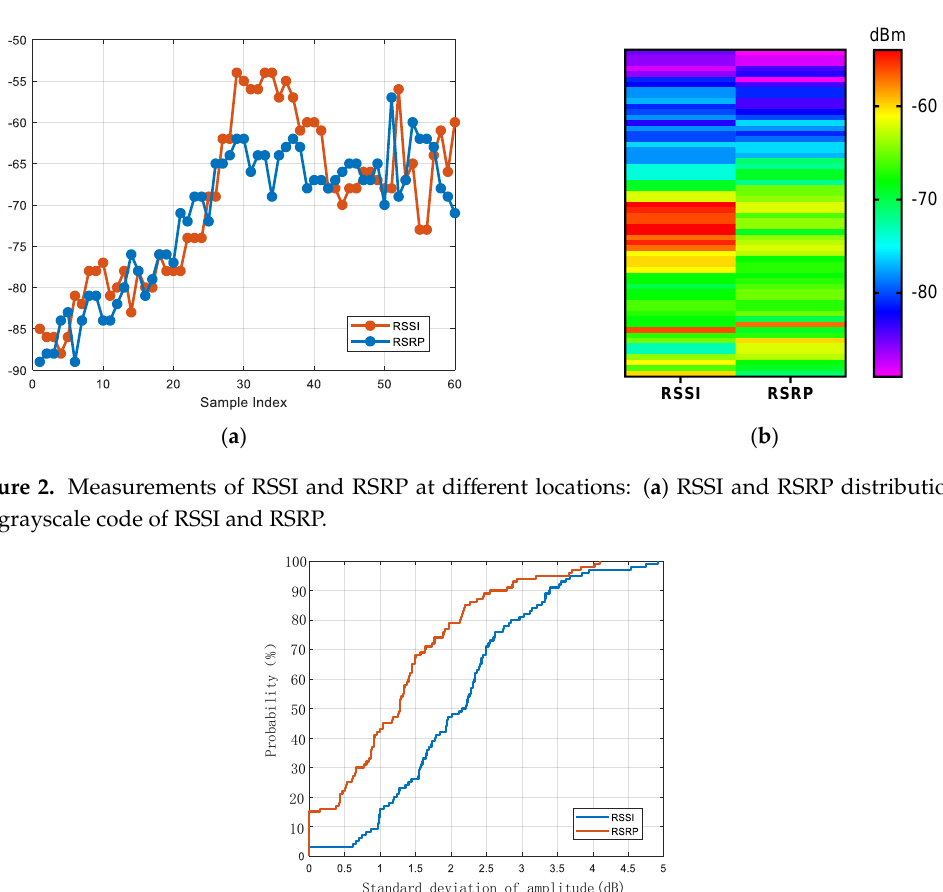
Figure 3. Cumulative distribution function (CDF) of the standard deviations of RSSI and RSRP amplitudes for 100 sampled locations.